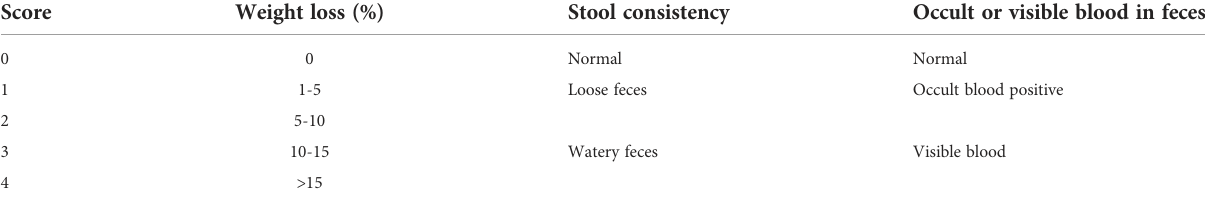
TABLE 1 Assessment of the colitis disease activity